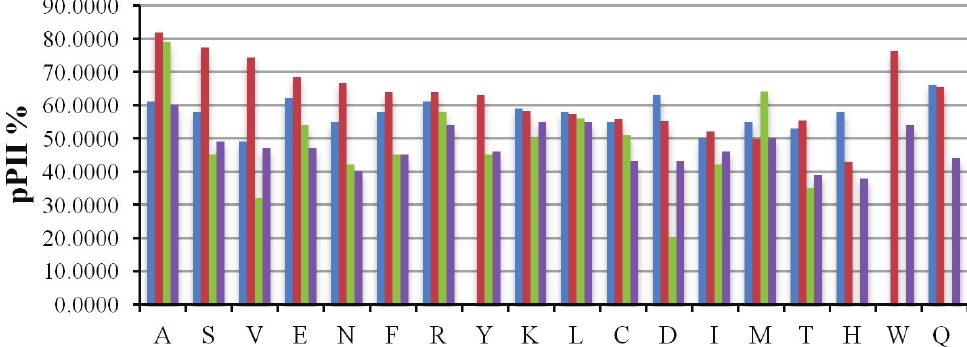
Figure 12. Comparison of ( a ) pPII; and ( b ) (cid:8)-strand populations for guest residues as obtained by Rucker et al. for PxP (blue) [163], Shi et al. for GGxGG (red) [51], Hagarman et al. for GxG (green) [52,77,138], and Grdadolnik et al. [76] for XdP (purple).